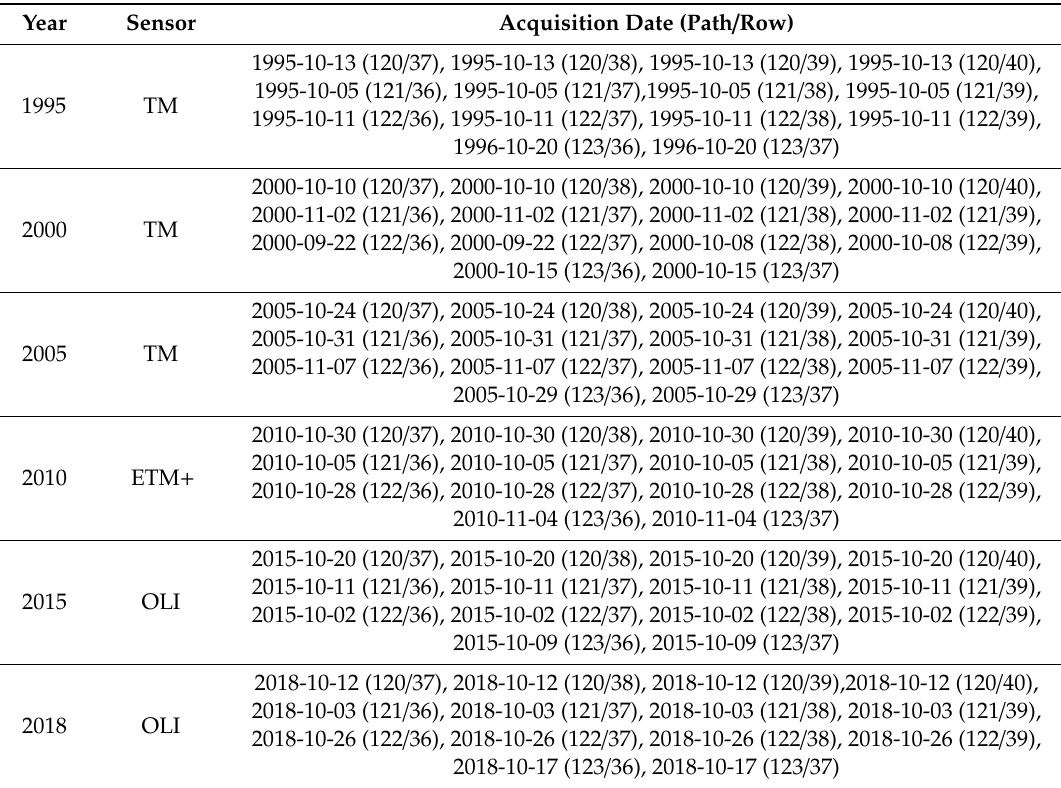
Table 1. Landsat image data used in this